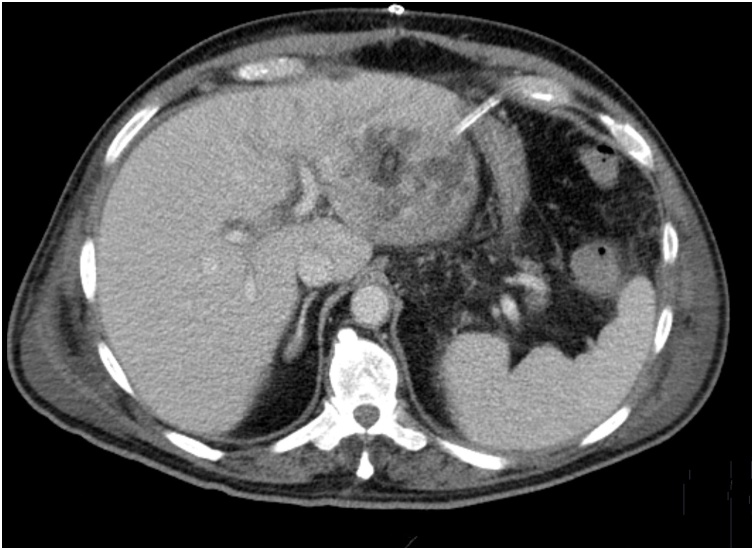
Abdominal CT scan seven days after surgical drainage. An ongoing multiloculated abscess in the left lobe is identified with a drain inside.